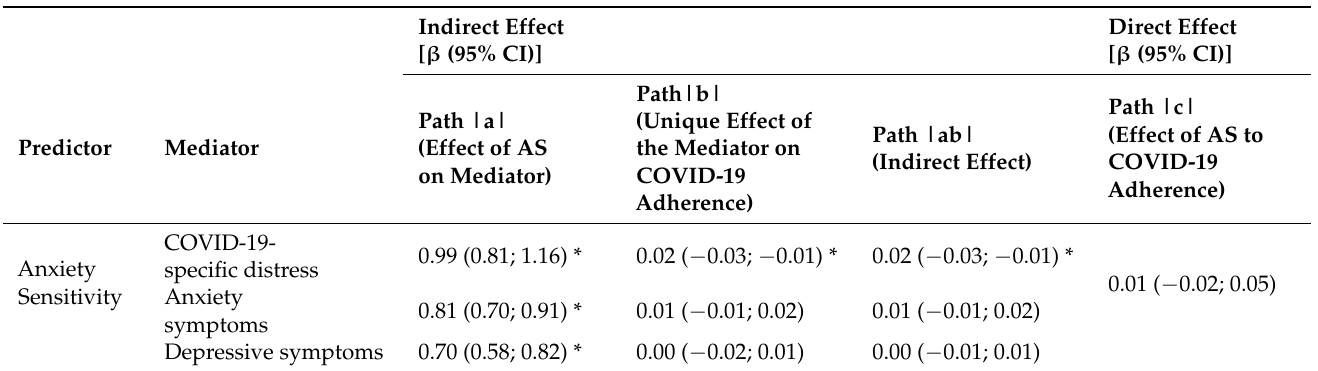
Table 5. Mediation of AS to COVID-19 adherence link through general distress (anxiety and depres- sive symptoms) and COVID-19-specific